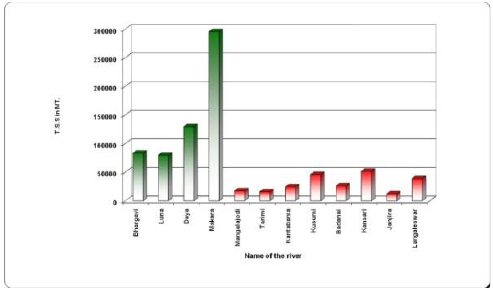
Figure 4. Sediment discharge into the lagoon during